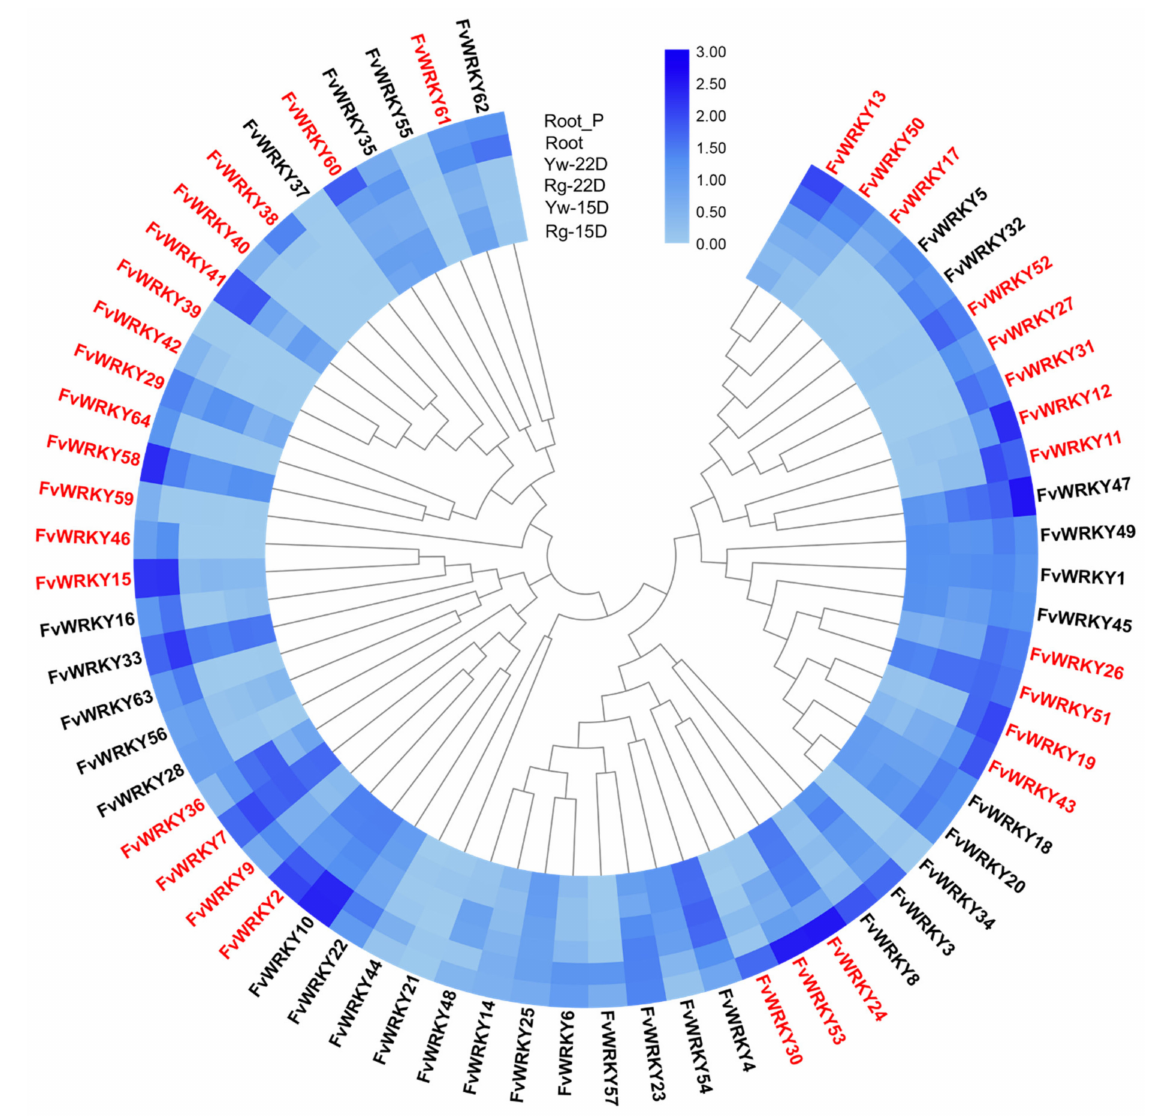
Figure 8. Phylogenetic tree of the FvWRKY family showing expression values during fruit ripening (Ruegen receptacle tissue at 15 and at 22 DPA and Yellow Wonder receptacle tissue at 15 and at 22 DPA: Yw-15D, Yw-22D, Rg-15D and Rg-22D, respectively) and roots (Root, collected from 7-week-old plants grown in aerated hydroponic culture, and Root_P, after 2 days of inoculation with Phytophthora cactorum ). FvWRKY paralogs are shown in red (see Table 1. Color scale represents the expression level as log-transformed TPM (Transcripts per Million)